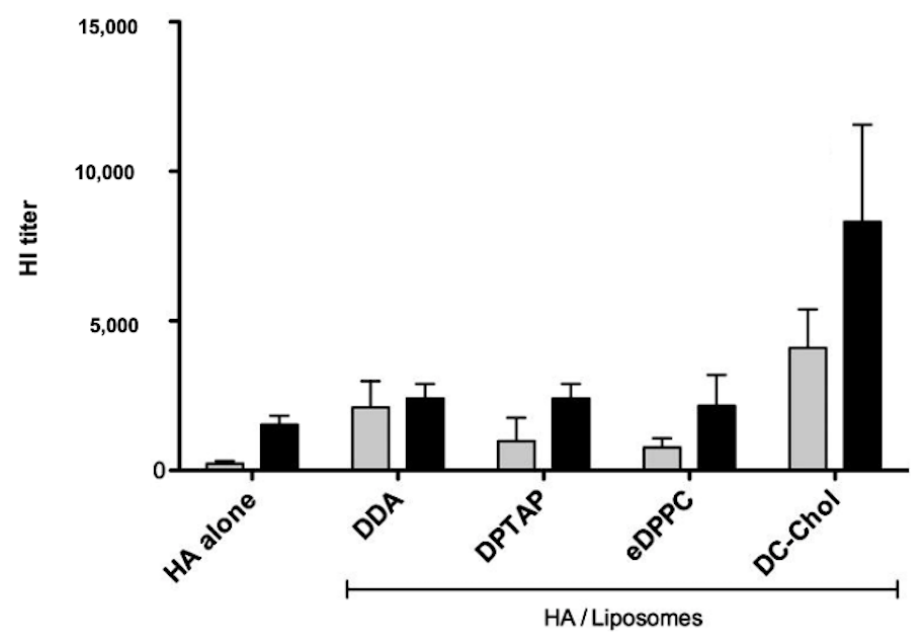
Figure 5. Hemagglutination inhibition (HI) assay for neutralizing antibodies against hemagglutinin (HA) elicited by combinations of HA with DDA / DPPC, DPTAP / DPPC, or DC-Chol / DPPC where DDA is dioctadecyldimethylammonium bromide, DPTAP is 1,2-dipalmitoyl-3-trimethylammonium-propane, DPPC is 1,2-dipalmitoyl-sn-glycero-3-phosphocholine, eDPPC is 1,2-diacyl-sn-glycero-3- ethylphosphocholine and DC-Chol is 3β-[ N -( N ′, N ′-Dimethylaminoethane)-carbamoyl] cholesterol. Reprinted from [89] with permission from Elsevier, Copyright 2012.